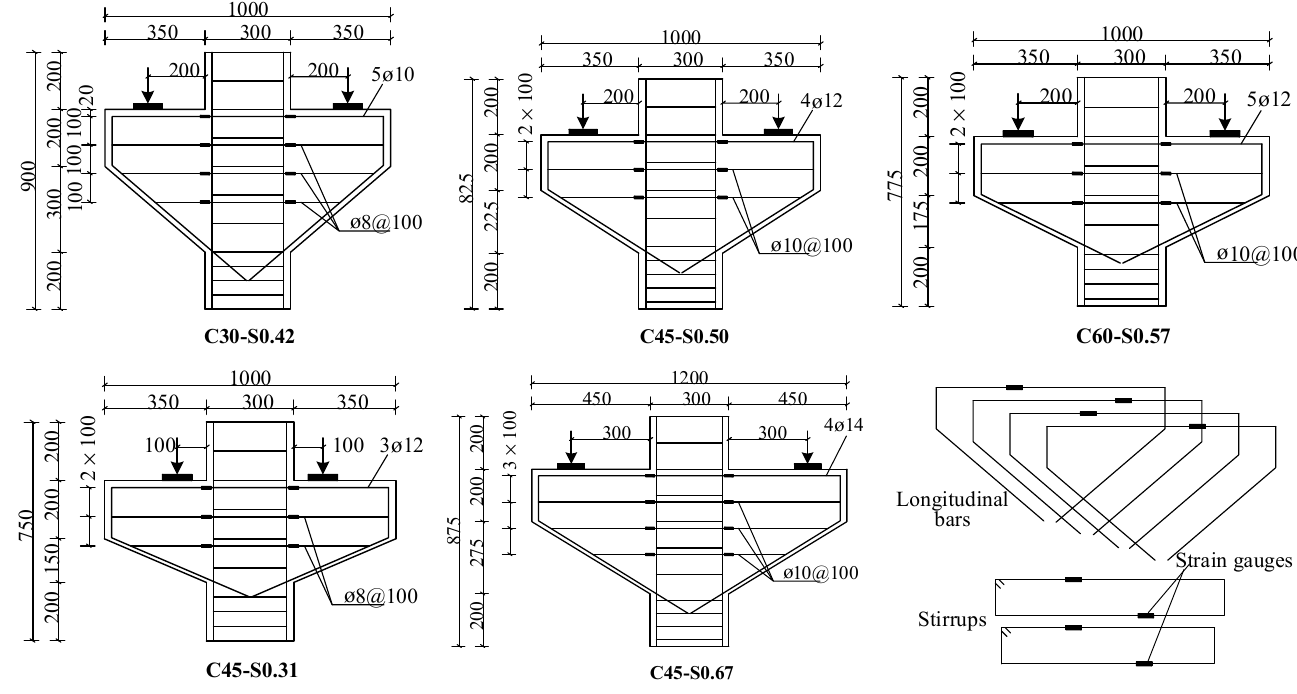
Figure 2. Layout of reinforcements and position of strain gauges. Note: Configuration of longitudinal bar in columns is 4ø20; Configurations of stirrups in columns are ø8@100 and ø8@50.